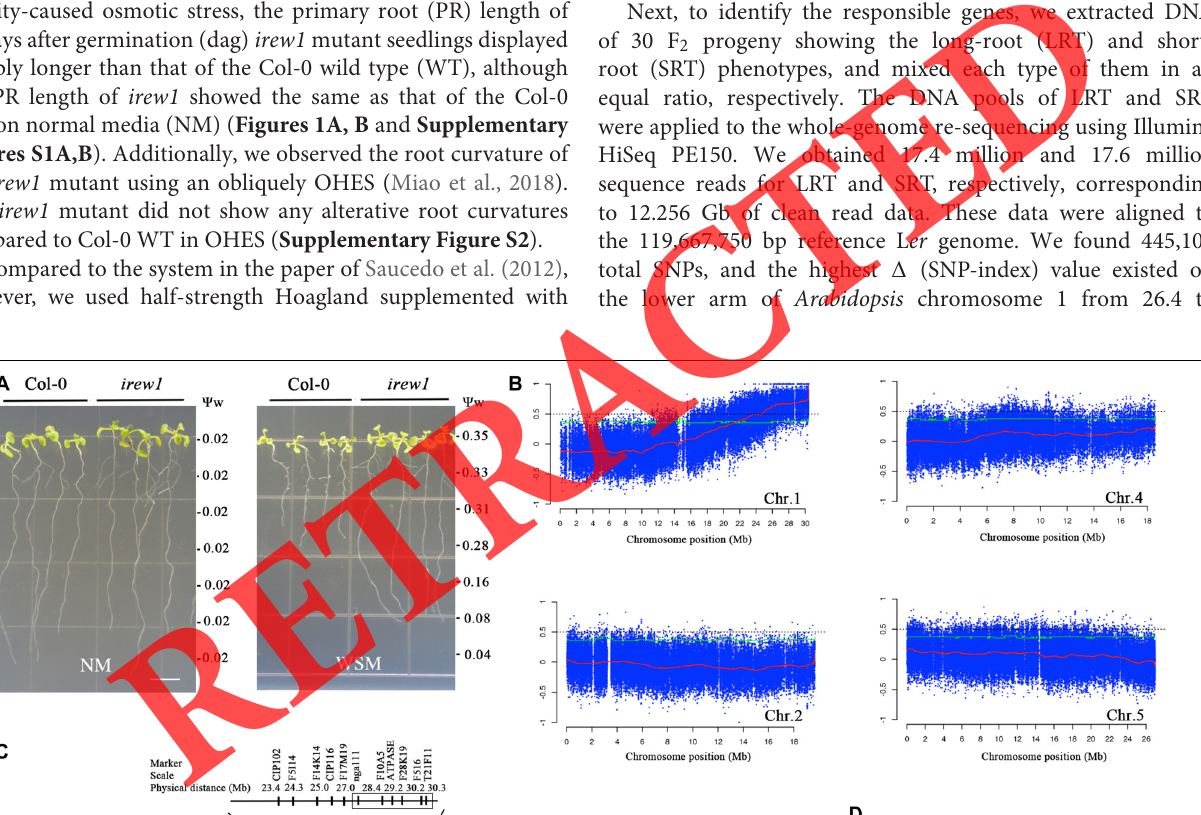
Frontiers in Plant Science |